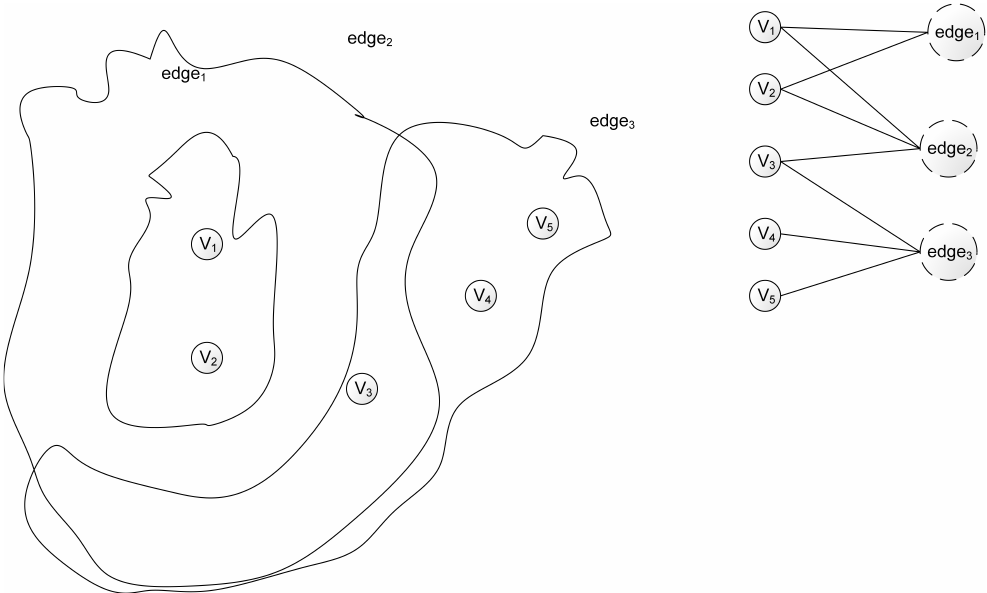
Figure 6. Bipartite